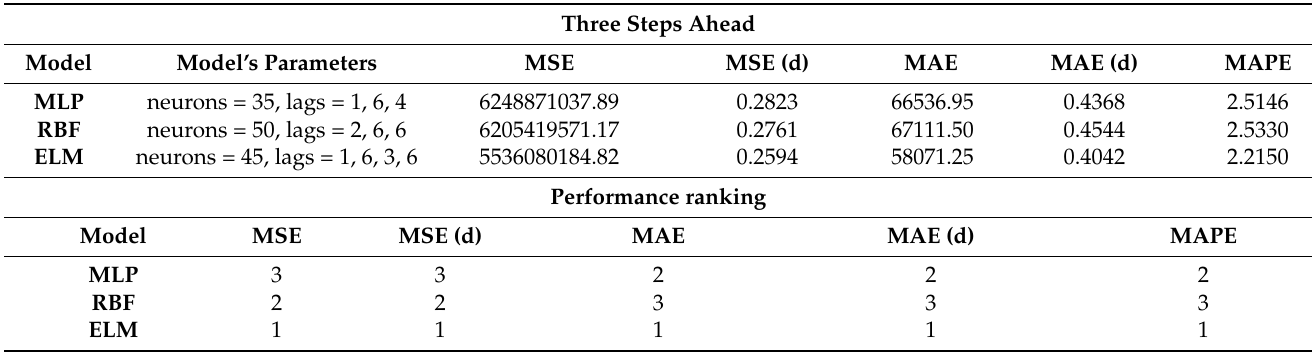
Figure 9. Graph comparing actual data with data predicted for one step ahead, using MLP, RBF, and ELM.